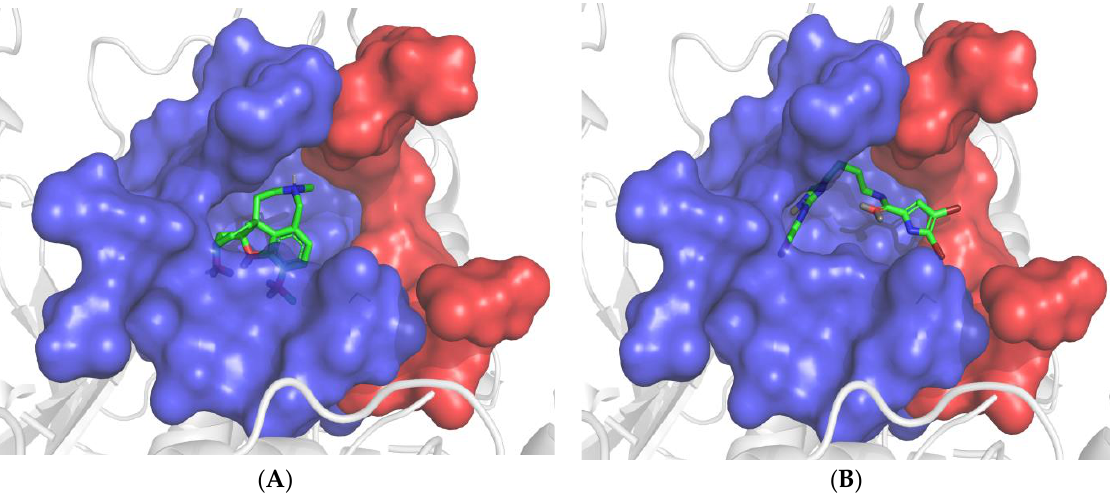
Figure 4. Prediction binding mode of galantamine ( A ) and N-acetyl-17-oroidine ( B ) into the whole BChE active pocket. The same color pattern used in Figure 3 was used.